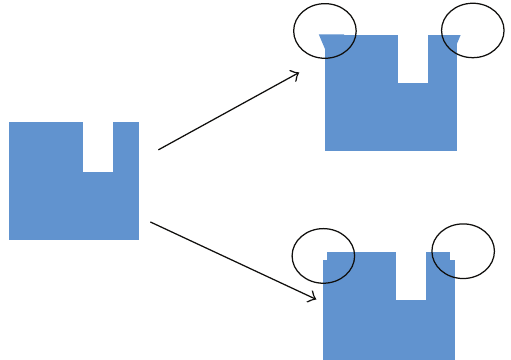
Figure 8: Examples of block-edge design modifications to improve measurement accuracy and